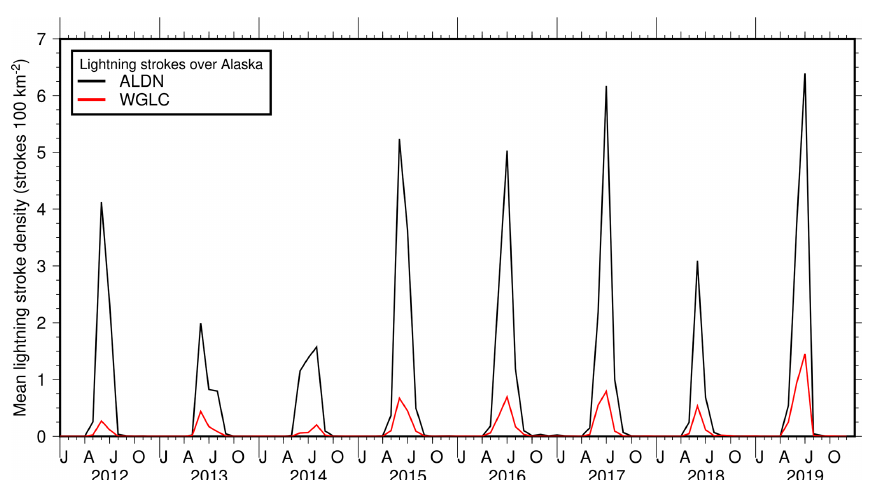
Figure 10. Time series of global median lightning stroke power.